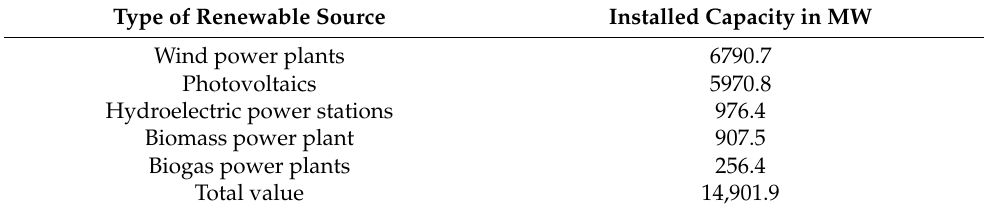
Table 5. Types of energy sources in Poland as of 30 August